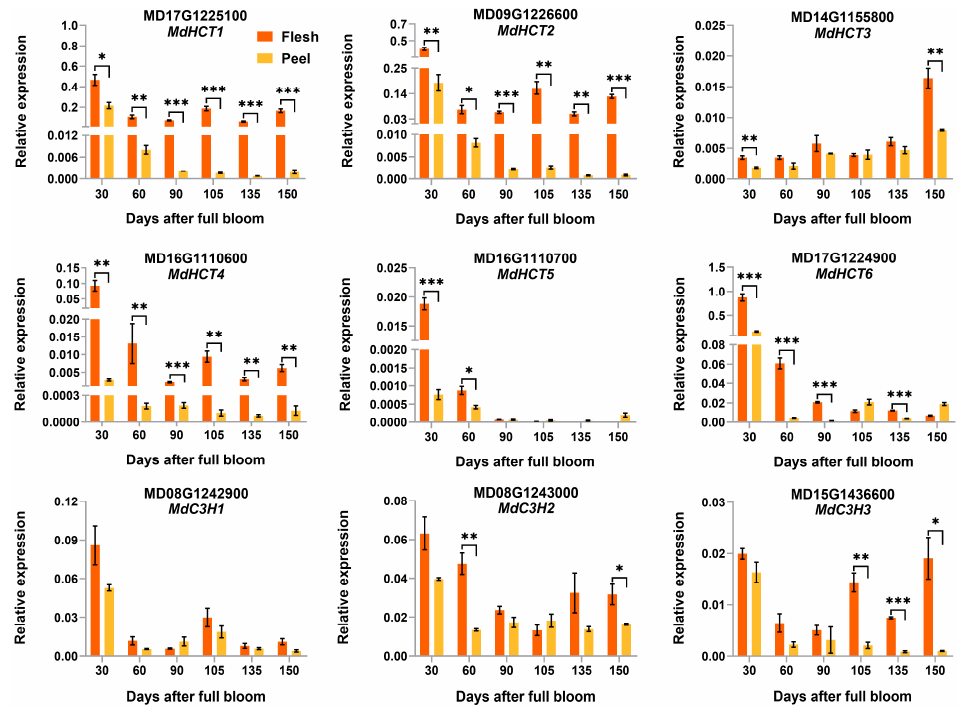
Figure 6. The relative expression levels of genes related to chlorogenic acid biosynthesis during fruit development in ‘Red Love’ apples. Dark orange columns and light orange columns represent the expression levels of the genes in the flesh and the peel of the fruit, respectively. Error bars represent standard errors from three biological replicates. (* p < 0.05, ** p < 0.01, *** p < 0.001).